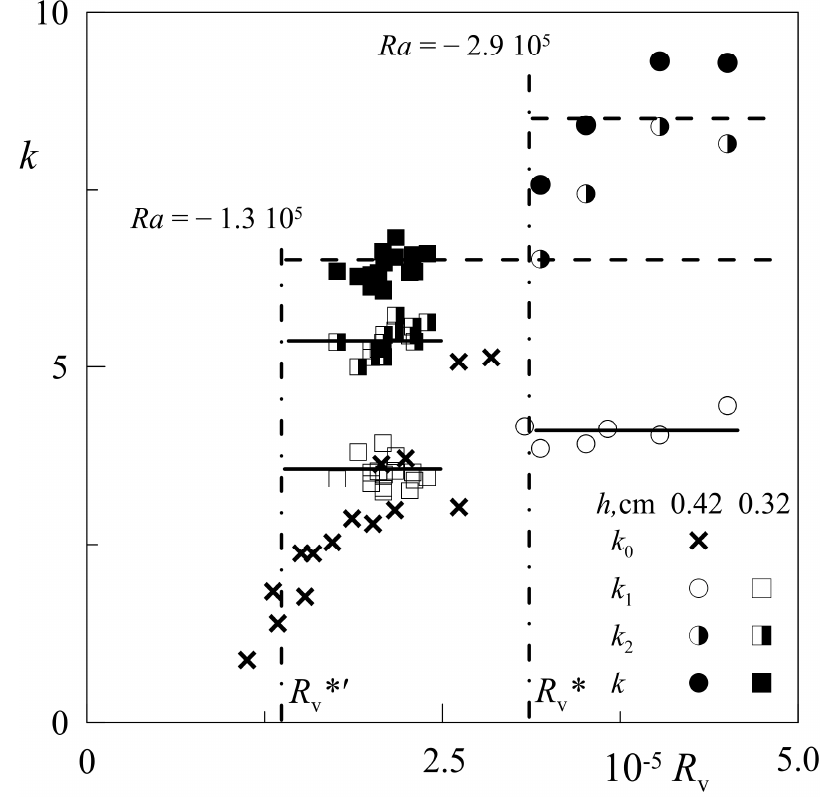
Figure 6. The dimensionless wavenumbers of different structures depending on the vibrational pa- rameter R v . Crosses and circles correspond to the experiments with a layer of thickness h = 0.42 cm at Ra ≈ − 2.9 · 10 5 , squares—to experiments with a layer of thickness h = 0.32 cm at Ra ≈ − 1.3 · 10 5 (thermochromic methodic of convective patterns visualization). The horizontal dashed line shows the theoretical values of the wavenumber k in the threshold at corresponding values of Ra [13]. The dash-dotted vertical lines show the critical values of vibrational parameter R v at corresponding values of Ra